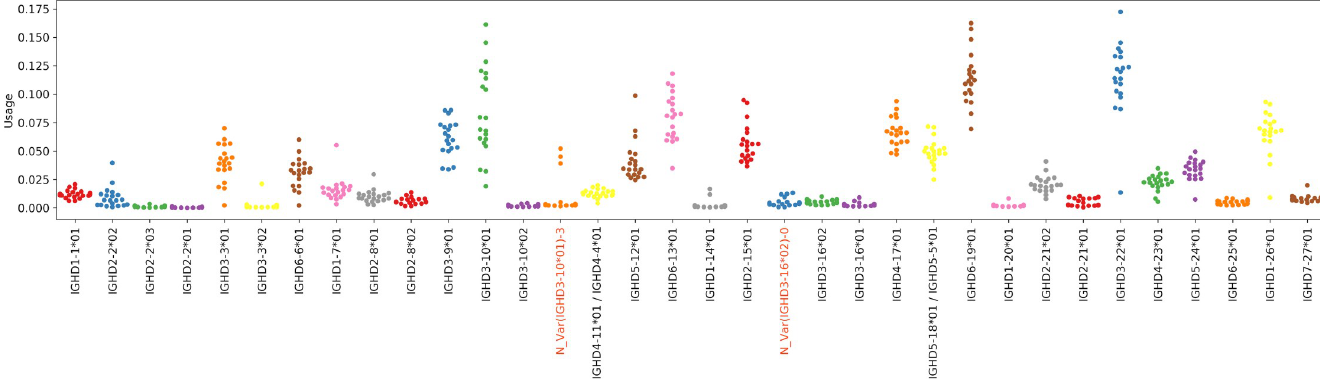
Fig 11. D gene usage in all Healthy datasets. Each point above a gene represents a Healthy Human PBMC dataset. To distinguish usages of different genes, adjacent genes are represented by different colors.